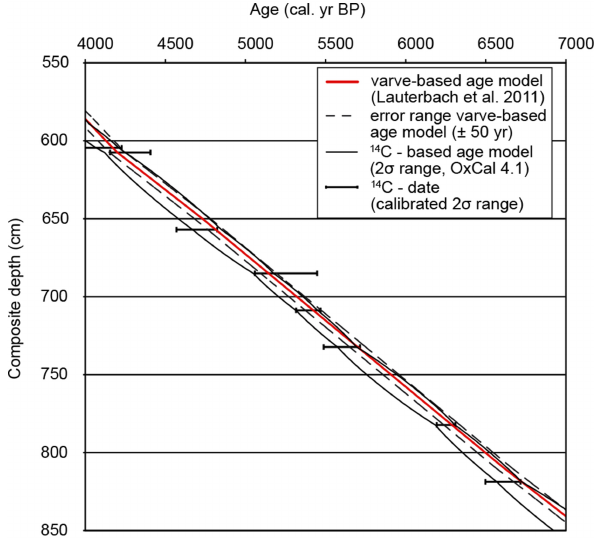
Fig. 2. Comparison of the primary varve-based age model (given with a counting uncertainty of ± 50yr as dashed lines) of the Lake Mondsee record (Lauterbach et al., 2011) and a secondary radiocarbon-based age model (2 σ probability range in grey), which has been established using OxCal 4.1 (Ramsey, 1995, 2001, 2008) to evaluate the reliability of the varve chronology. Individual AMS 14 C dates from terrestrial plant macrofossils, which are included in the radiocarbon-based age model are given with their 2 σ probability